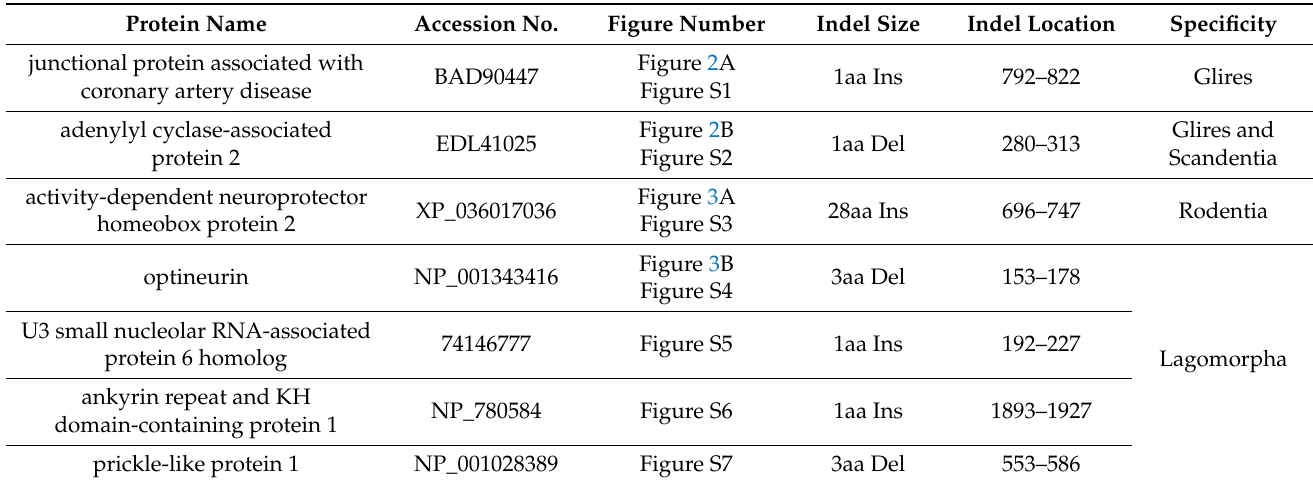
Table 1. Characteristics of the CSIs specific for the Glires, Rodentia, and Lagomorpha